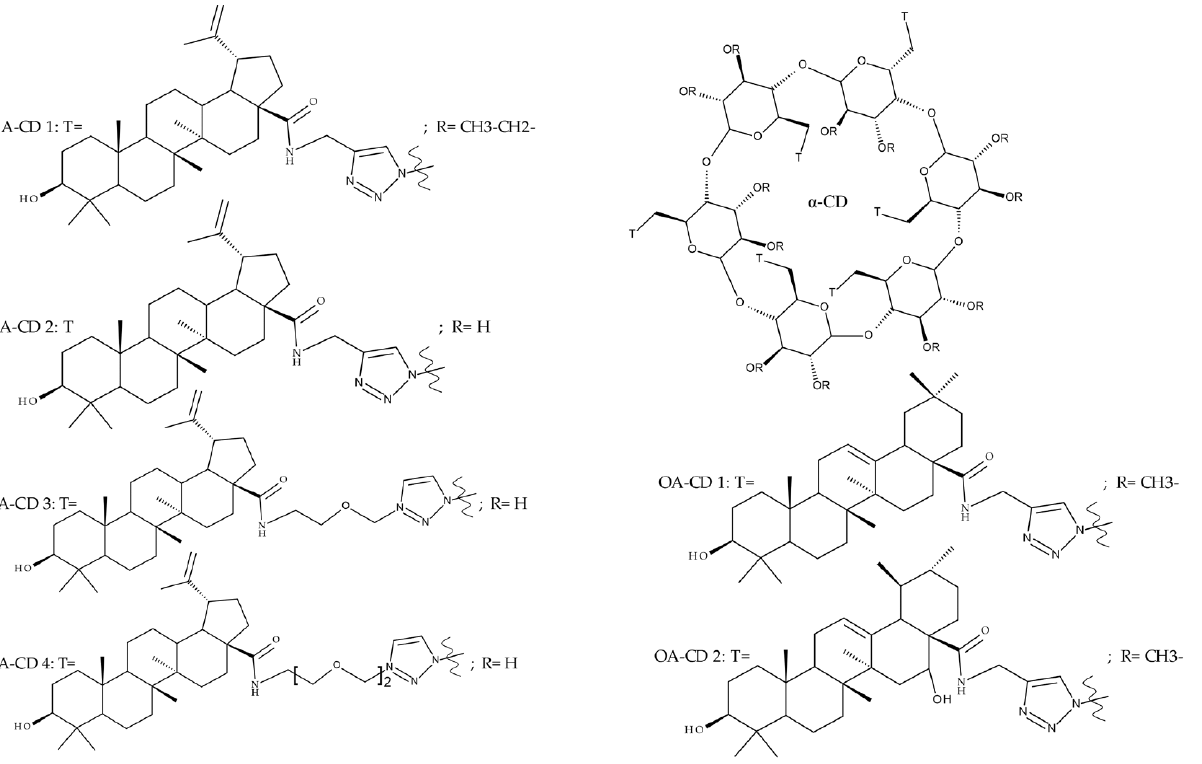
Figure 5. Derivatives of BA and OA with alpha-CD.